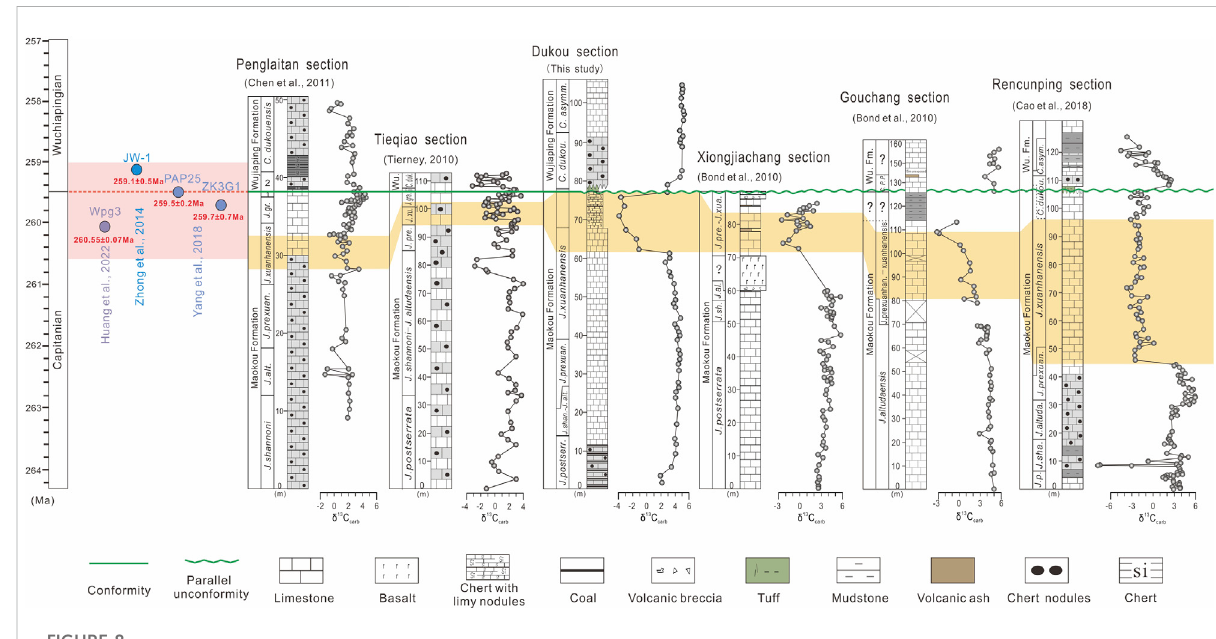
FIGURE 8 Carbon isotope chemostratigraphy of the South China during the GLB transition. The reported high-precision zircon U-Pb age data of the Emeishan LIP are from Zhong et al. (2014);Yang etal. (2018);Huang etal. (2022). The reported carbon isotopedata: Penglaitan section is from Chen et al. (2011); Tieqiao section is from Tierney. (2010); Xiongjiachang and Gouchang sections are from Bond et al. (2010); Rencunping section is from Cao et al. (2018). The age of Capitanian is from JTS-2022. 1 = Clarkina postbitteri hongshuiensis , 2 = Clarkina postbitteri